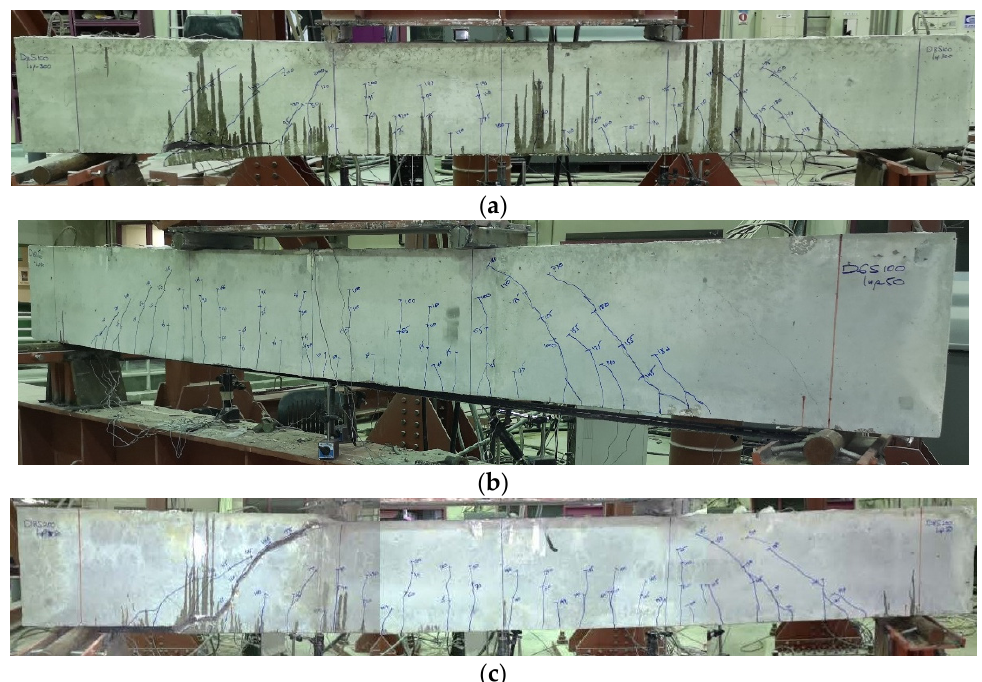
Figure 4. Cracking patterns of the tested beams at failure.